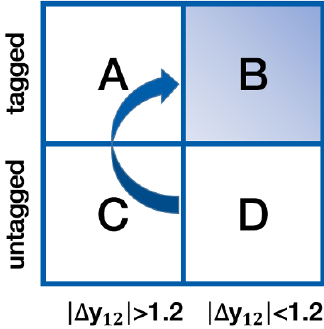
Figure 6 . Four orthogonal regions used to build the (cid:12)t control region for each signal region. A: j (cid:1) y j > 1 : 2 with both the jets boson-tagged, B: j (cid:1) y j < 1 : 2 with both the jets boson-tagged (this 12 12 is the nominal signal region), C: j (cid:1) y j > 1 : 2 with the event not boson-tagged, D: j (cid:1) y 12 with the event not boson-tagged. Regions A and C are used to derive a per-event transfer factor from region D to the (cid:12)t control region, which is representative of region B. A and C are also signal-depleted due to the j (cid:1) y j > 1 : 2 requirement. 12